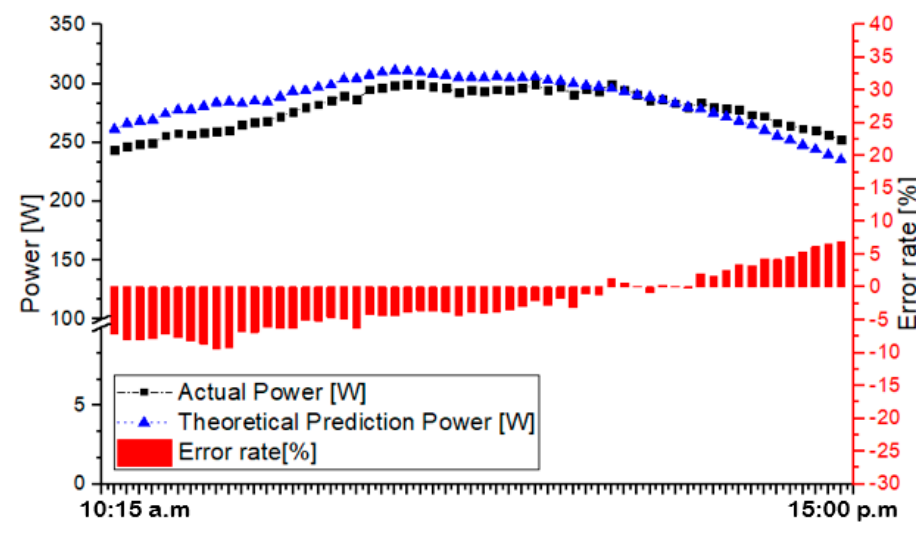
Figure 16. The error rate by comparing the modeling output with the measured data.